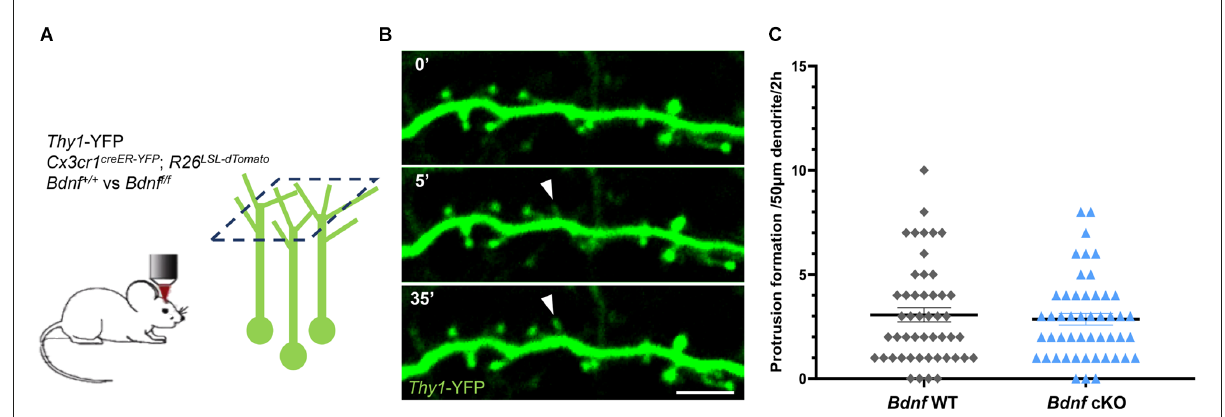
FIGURE1 Deletion of microglial Bdnf does not affect protrusion formation. (A) Paradigm to assess protrusion formation using two-photon in vivo imaging of Thy1 -YFP neurons in L1 of the motor cortex at P60. Thy1 -YFP; Cx3cr1 creER − YFP / + ; R26 LSL − tdTomato / + ; Bdnf +/+ (named Bdnf WT) mice and their Thy1 -YFP; Cx3cr1 creER − YFP / + ; R26 LSL − tdTomato / + ; Bdnf f / f littermates ( Bdnf cKO) were imaged over 2 h at one image every 5 min. (B) Representative time sequence of protrusion formation (full arrowhead). (C) No difference in protrusion formation was observed between Bdnf WT and Bdnf cKO mice littermates at P60 ( n = 49 dendrites from seven animals in each group, p = 0.91, Mann-Whitney test). Scale bar: 5 µ